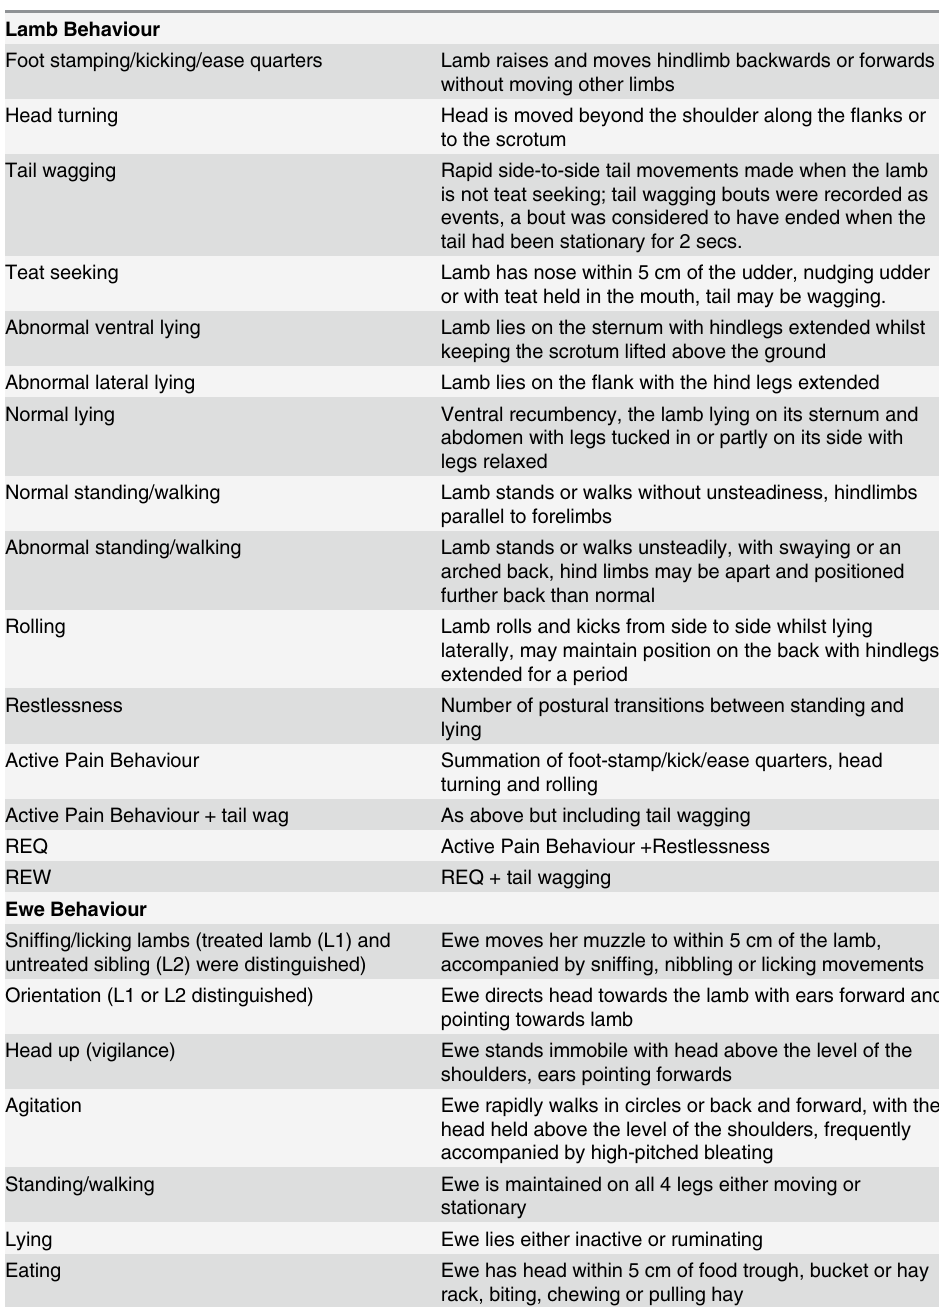
Table 2. Definitions of lamb and ewe behaviours recorded in the first 30 min following different castra- tion treatments or sham castration. Lamb behaviours, except postures and teat seeking, were recorded as events; ewe behaviours, lamb postures and teat seeking were recorded as